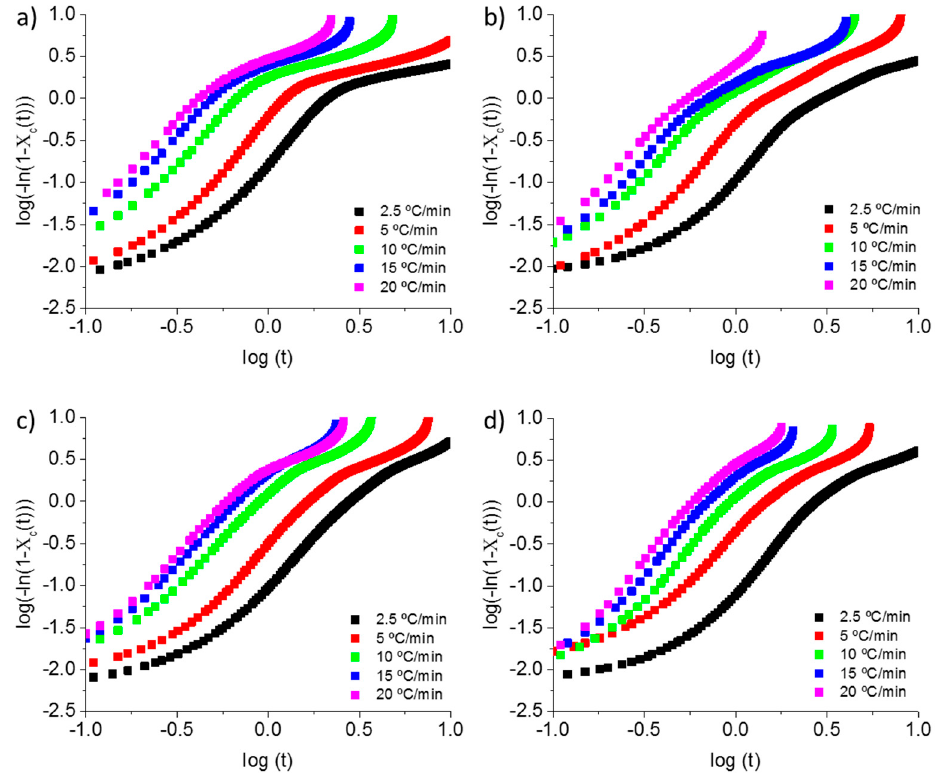
Figure 4. Modified Avrami plots at various cooling rates. ( a ) neat PEEK, ( b ) PEEK/GNP (1 wt %) ( c ) PEEK/GNP (5 wt %), and ( d ) PEEK/GNP (10 wt %).